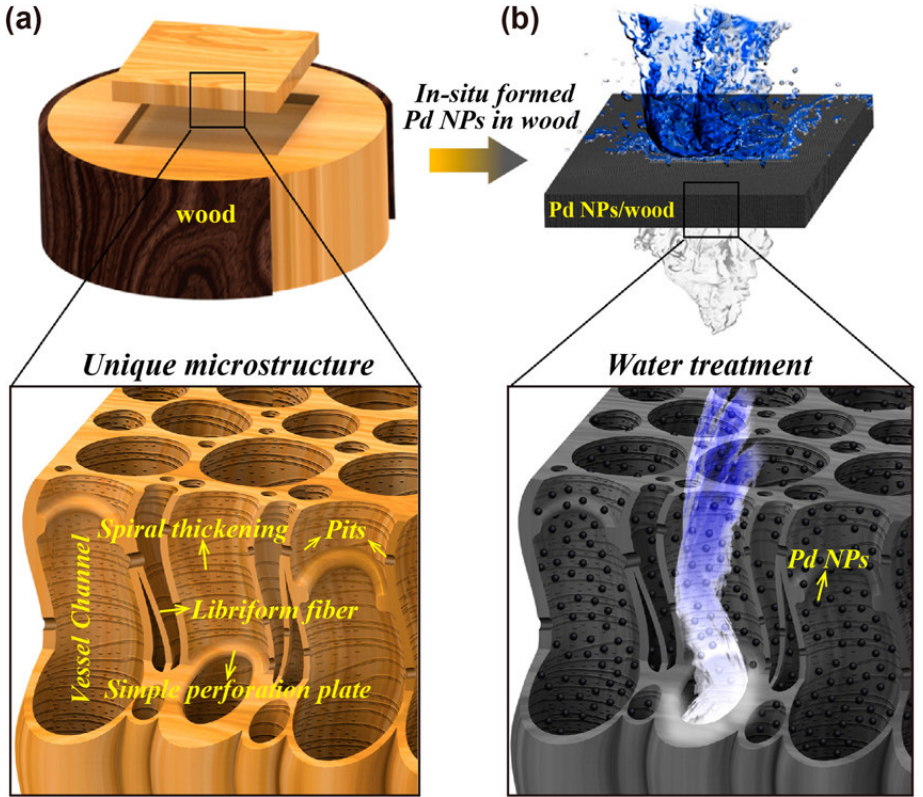
Figure 4. Basswood decorated with Pd NPs for water treatment. The zoom-in images show: ( a ) mes- oporous structure of the wood perpendicular to the growth direction; ( b ) in-situ formed Pd NPs in wood where lignin acts as the reducing agent. “Reproduced with permission from [138]. American Chemical Society, 2017” [139]) .